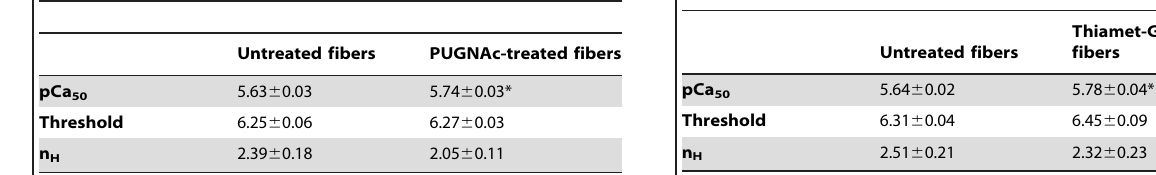
Table 1. Activation threshold, pCa 50 and Hill parameter values of skinned fibers isolated from untreated and PUGNAc- treated soleus.